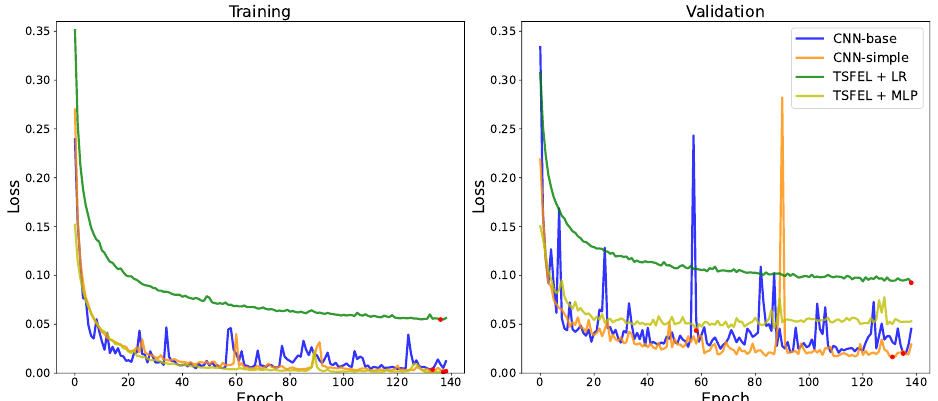
Figure 5. Evolution of loss by epoch on SAD dataset in the OOD-U setting. The red dots indicate the minimum loss of each